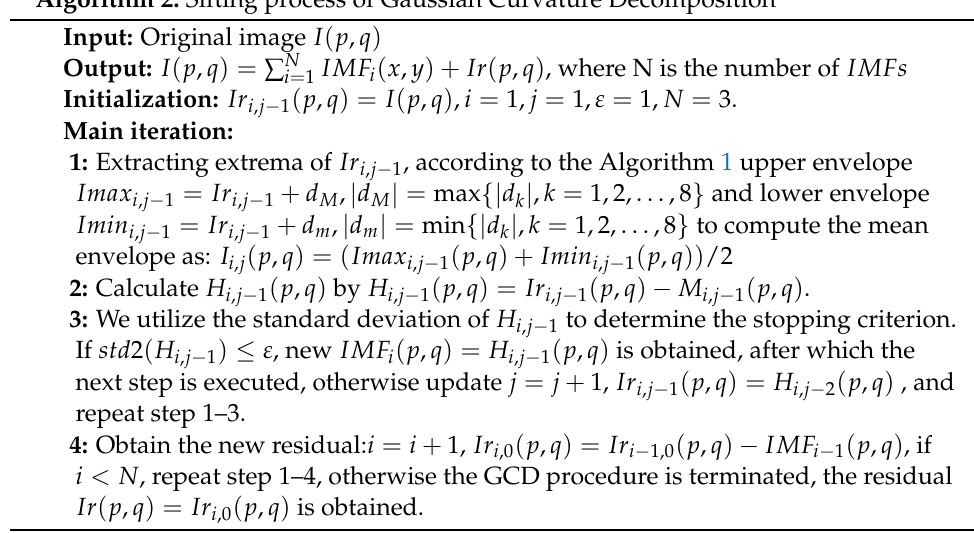
Algorithm 2: Sifting process of Gaussian Curvature Decomposition